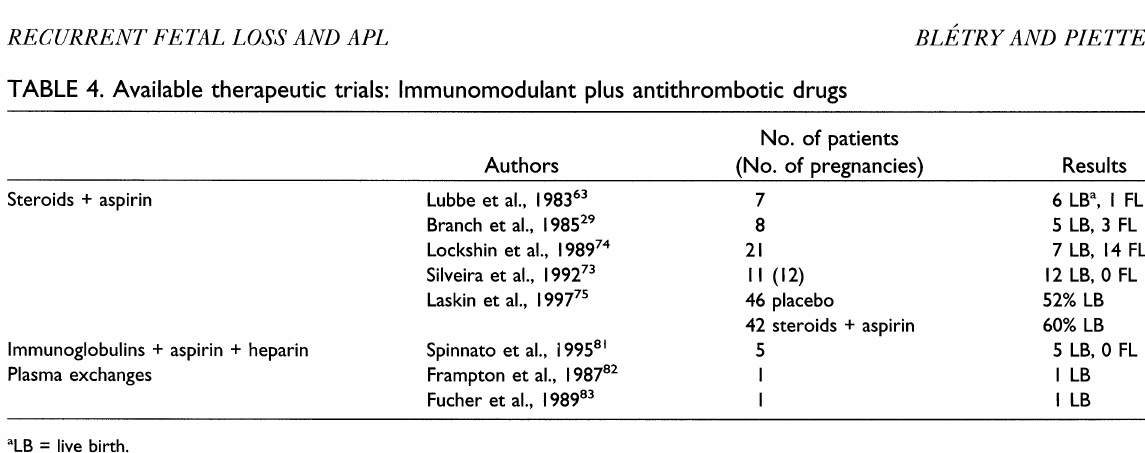
TABLE 4. Available therapeutic trials: Immunomodulant plus antithrombotic drugs